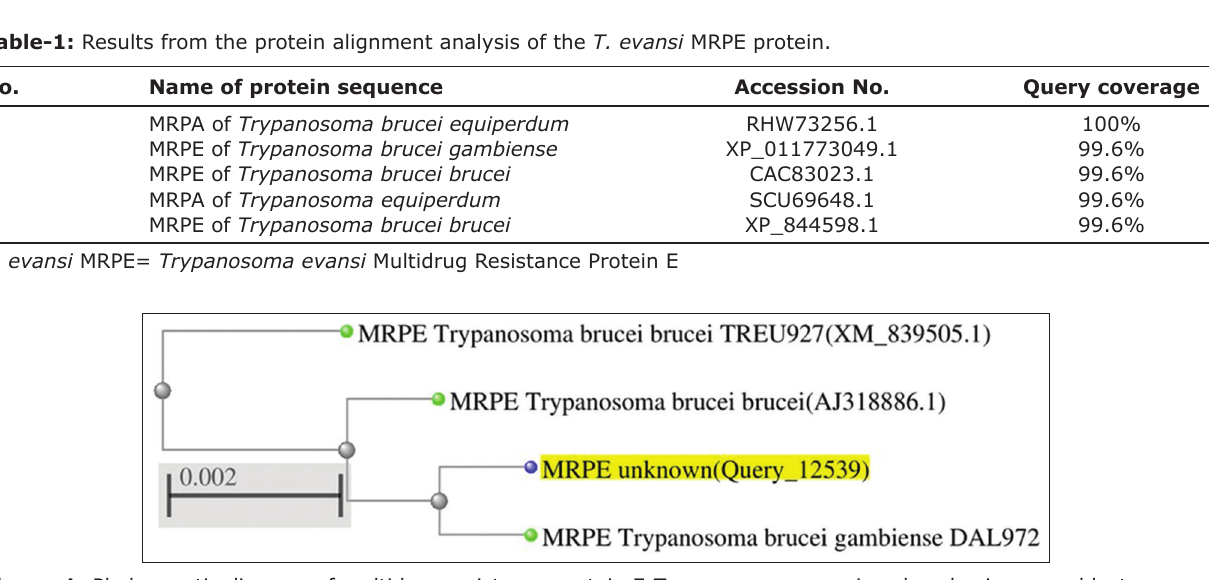
Figure-1: Phylogenetic diagram of multidrug resistance protein E Trypanosoma evansi analyzed using megablast.